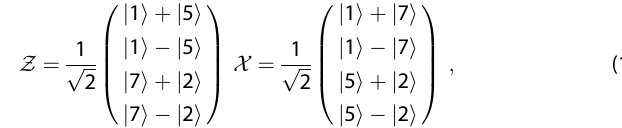
Fig. 1 Induced interference fringes with active modulation. a Polarization aligned to the phase modulator. Acquired counts from